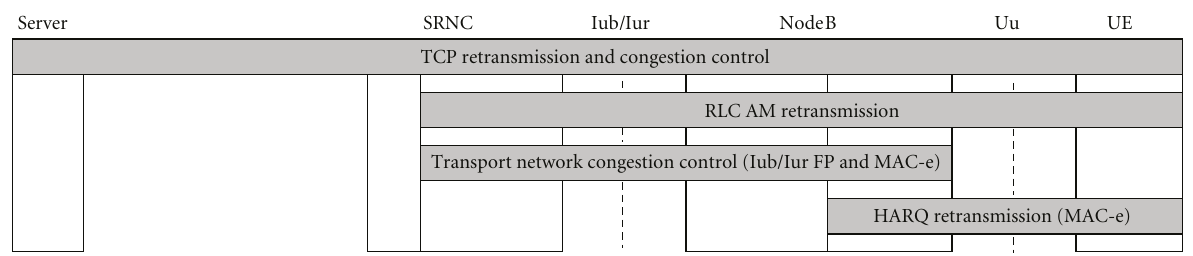
Figure 2: Protocol layers performing congestion control and/or